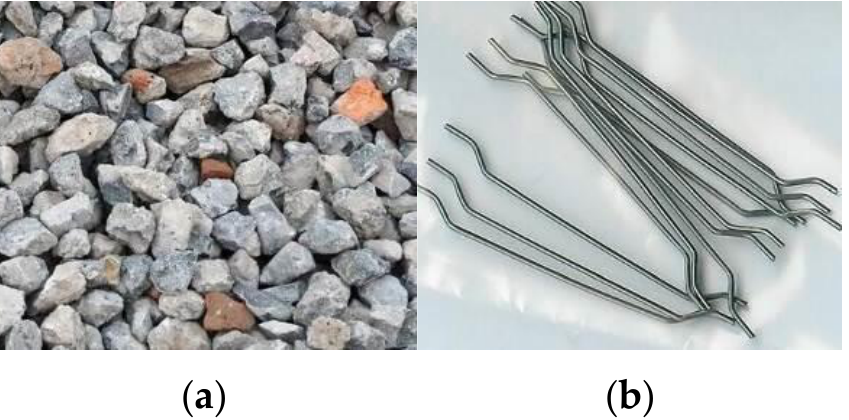
Figure 1. Experiment materials. ( a ) Recycled aggregate. ( b ) Steel fibers. Table 4. Mechanical properties of the steel.